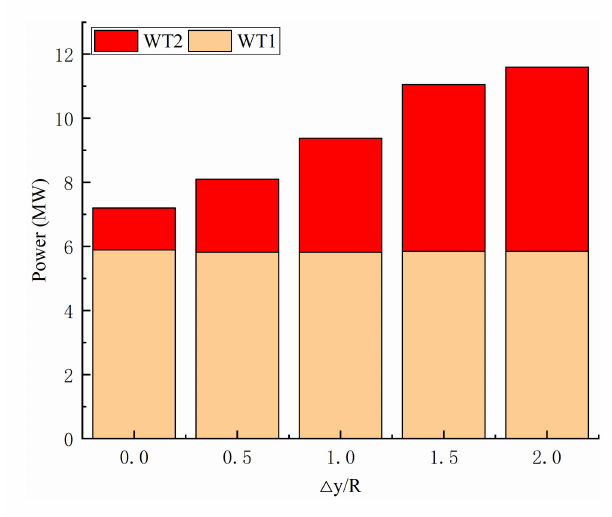
Figure 9. The output power of WT-1 and WT-2 for each